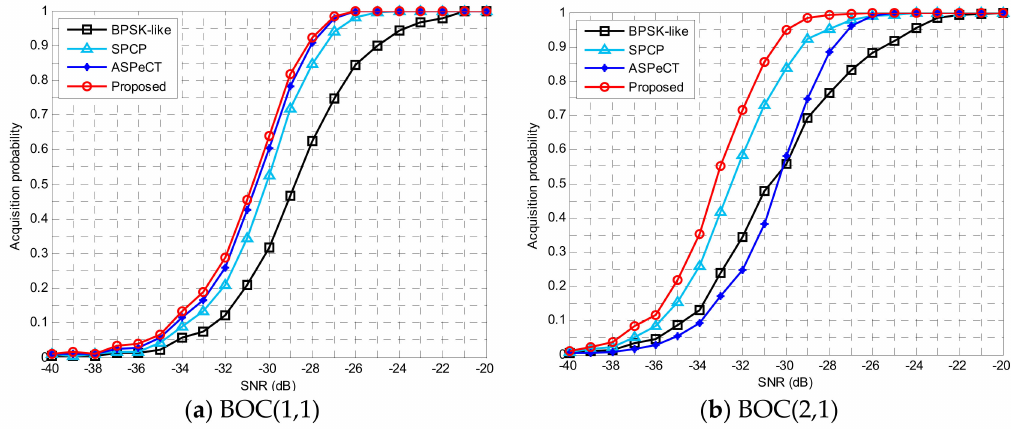
Figure 15. The acquisition